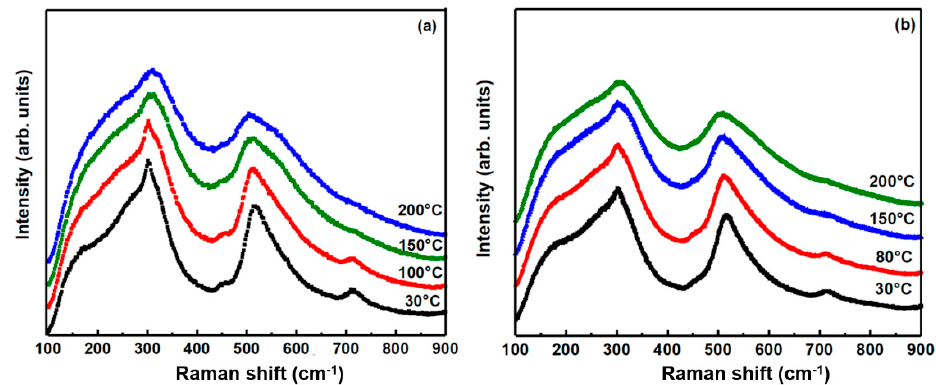
Figure 3. ( a ) Raman spectra of undoped BT-NBT ceramics at different temperatures; ( b ) Raman spectra of BT-NBT-YM ( x = 0.015) ceramics at different temperatures.